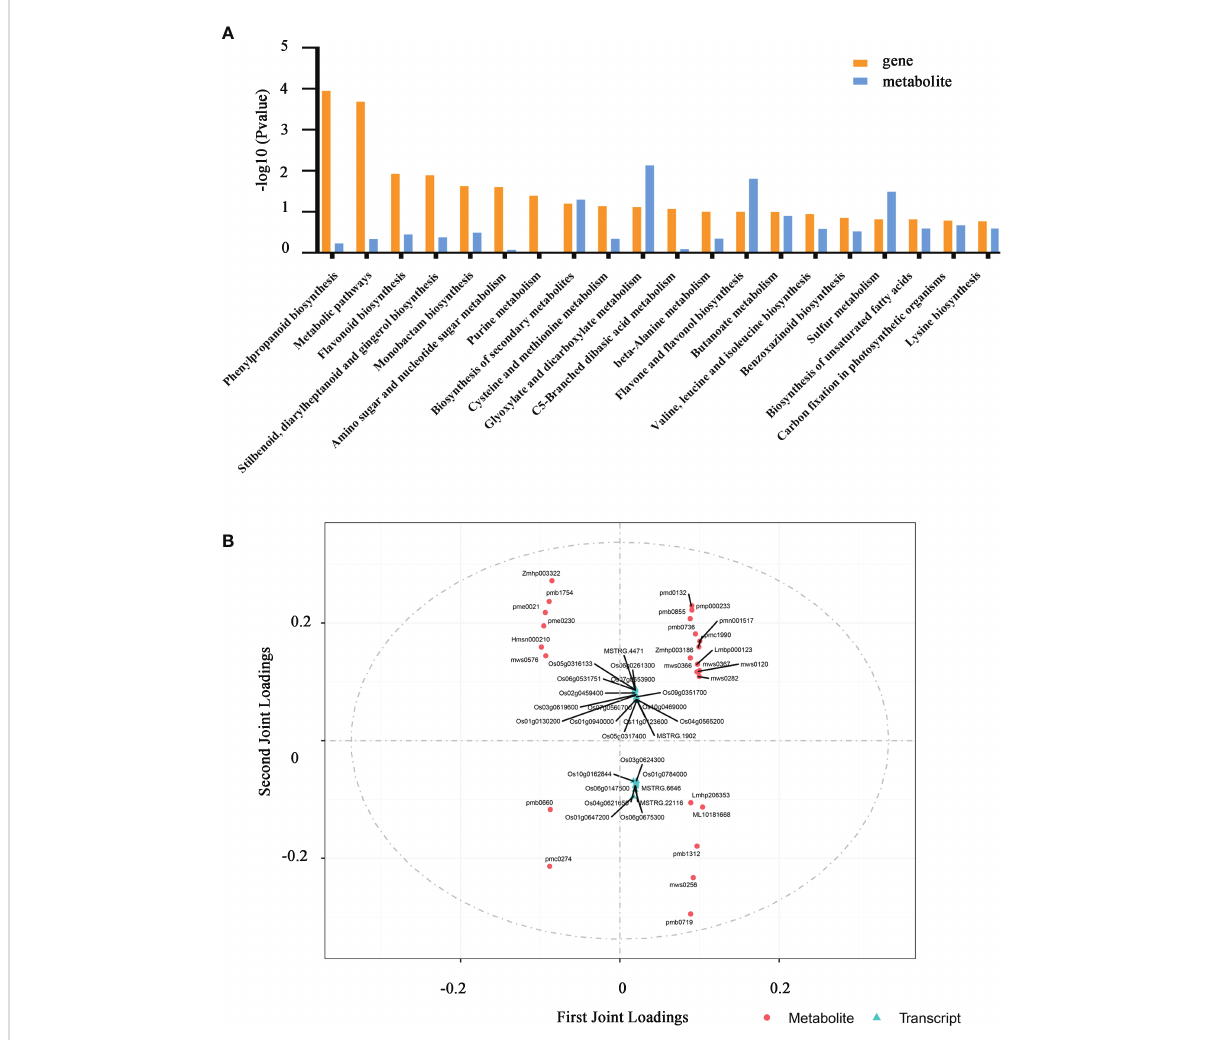
FIGURE 6 Combined analysis of the transcriptome and metabolome. (A) KEGG enrichment analysis of DAMs and DEGs between osseh1 lines and WT plants under cold stress. (B) Loading values representation of genes and metabolites from transcriptome and metabolome Tables based on two- way orthogonal partial least squares (O2PLS)